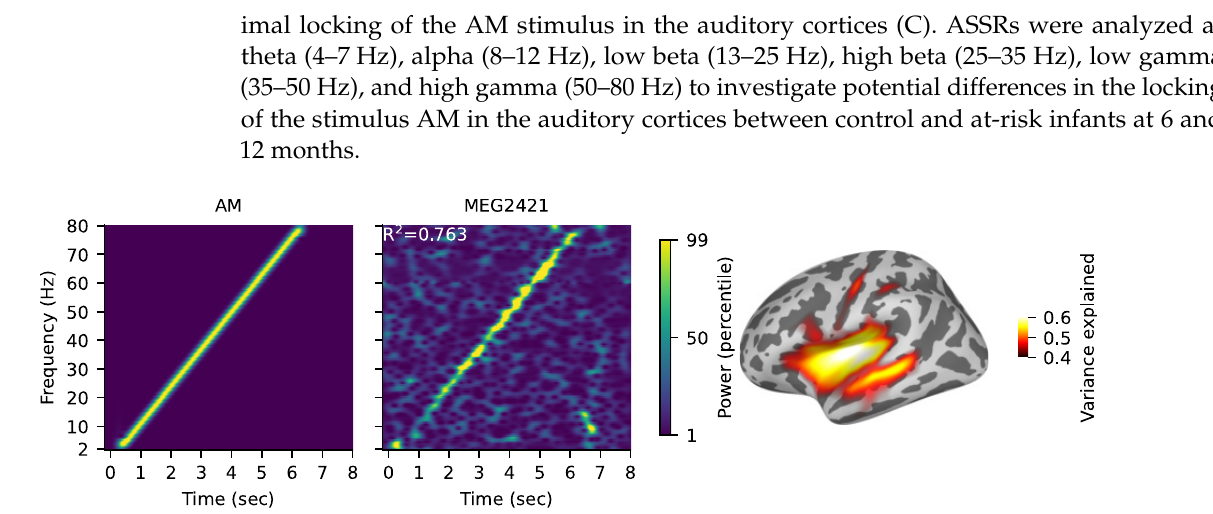
Table 2. LME results for group difference ( n = 53) at each frequency band.